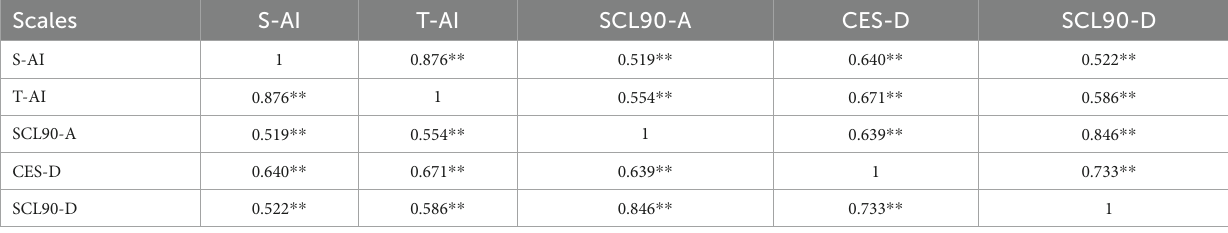
TABLE 5 Pearson’s correlation between anxiety and depression.